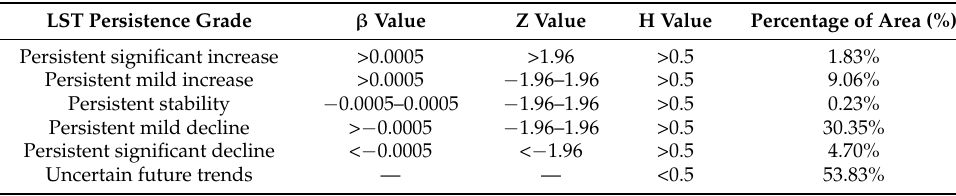
Table 4. Persistence classification of